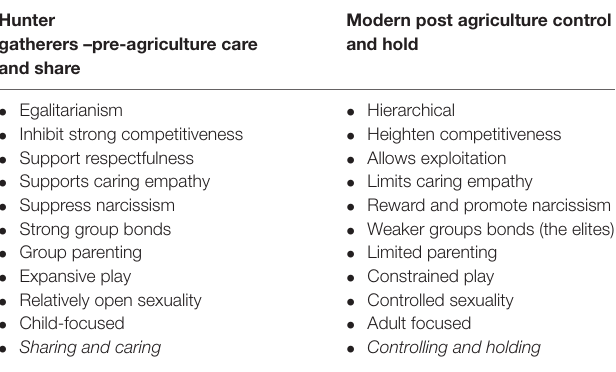
TABLE 1 | Differentiating biopsychosocial processes according to evolved resource regulation strategies Distinguishing